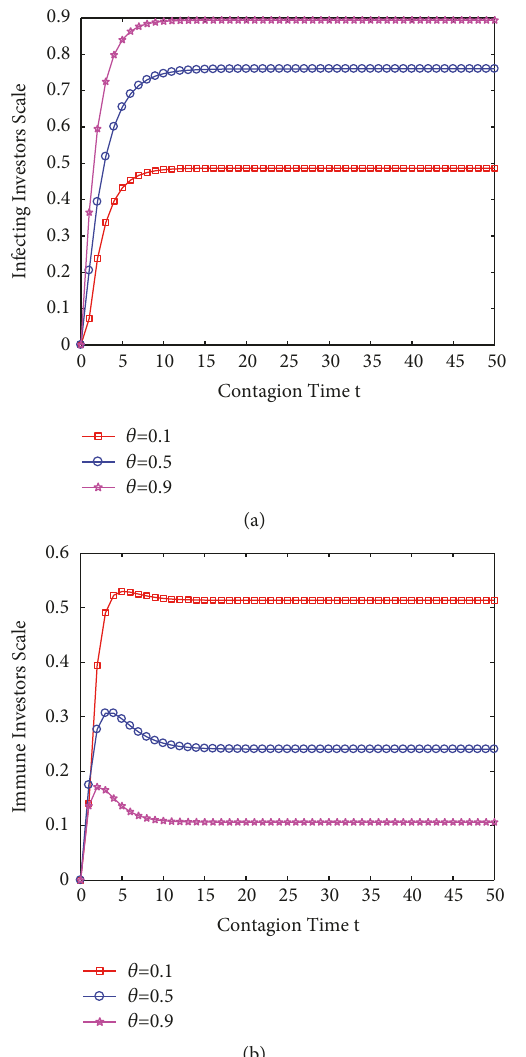
Figure 8: Changes in the scale of infecting investors and immune investors with the contagion time under different investor risk preference 𝜃